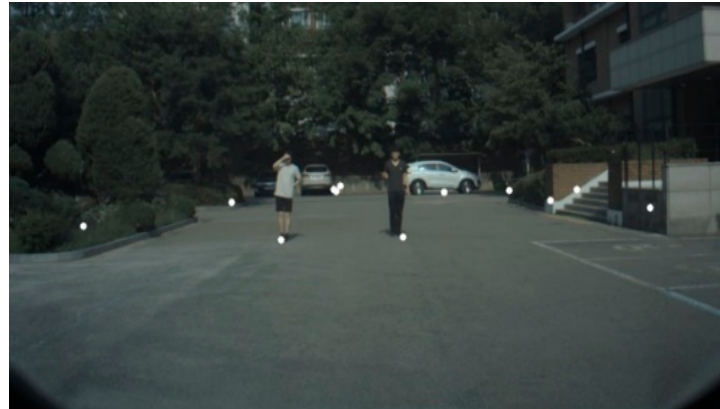
Figure 14. The result of projecting the radar detection result in the image coordinate system.